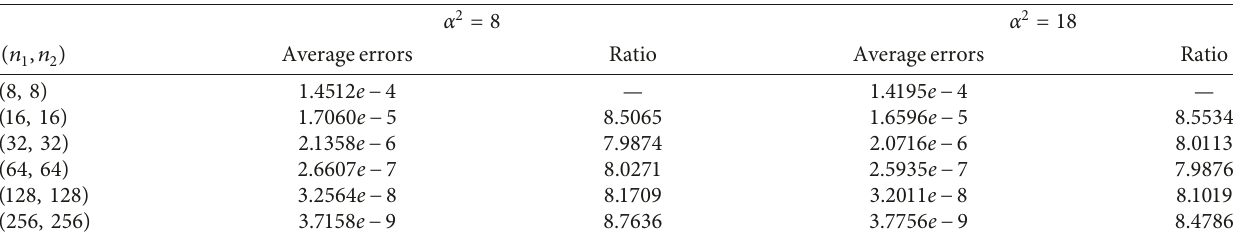
Table 2: The simulation results for Example